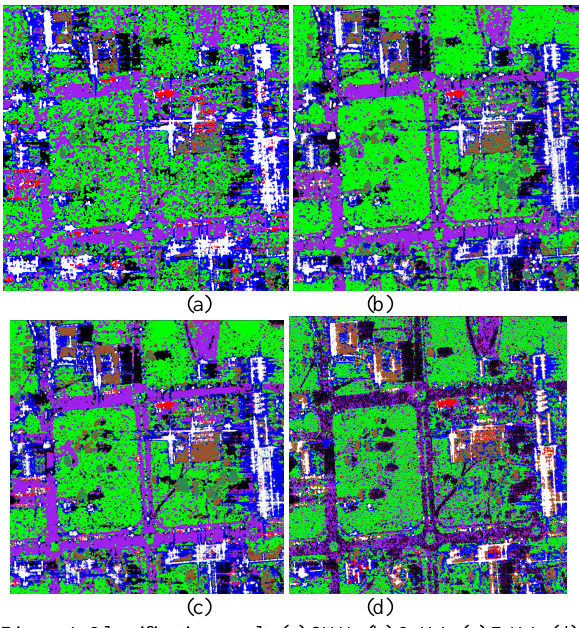
Figure 4: Classification result: (a) SVM (b) G-ML (c) F-ML (d) Wishart